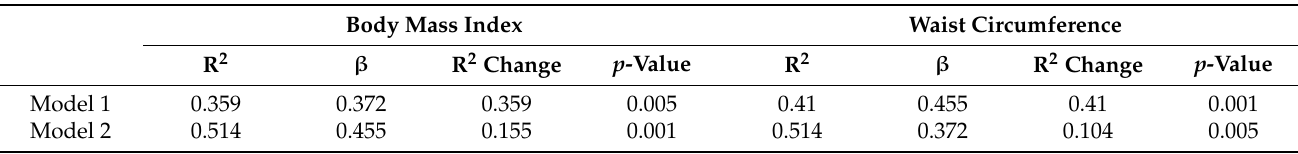
lipoprotein ratio. * p < 0.05. Table 4. Standardized regression coefficients examining the association of BMI and WC with clustered metabolic risk in the South Asian.